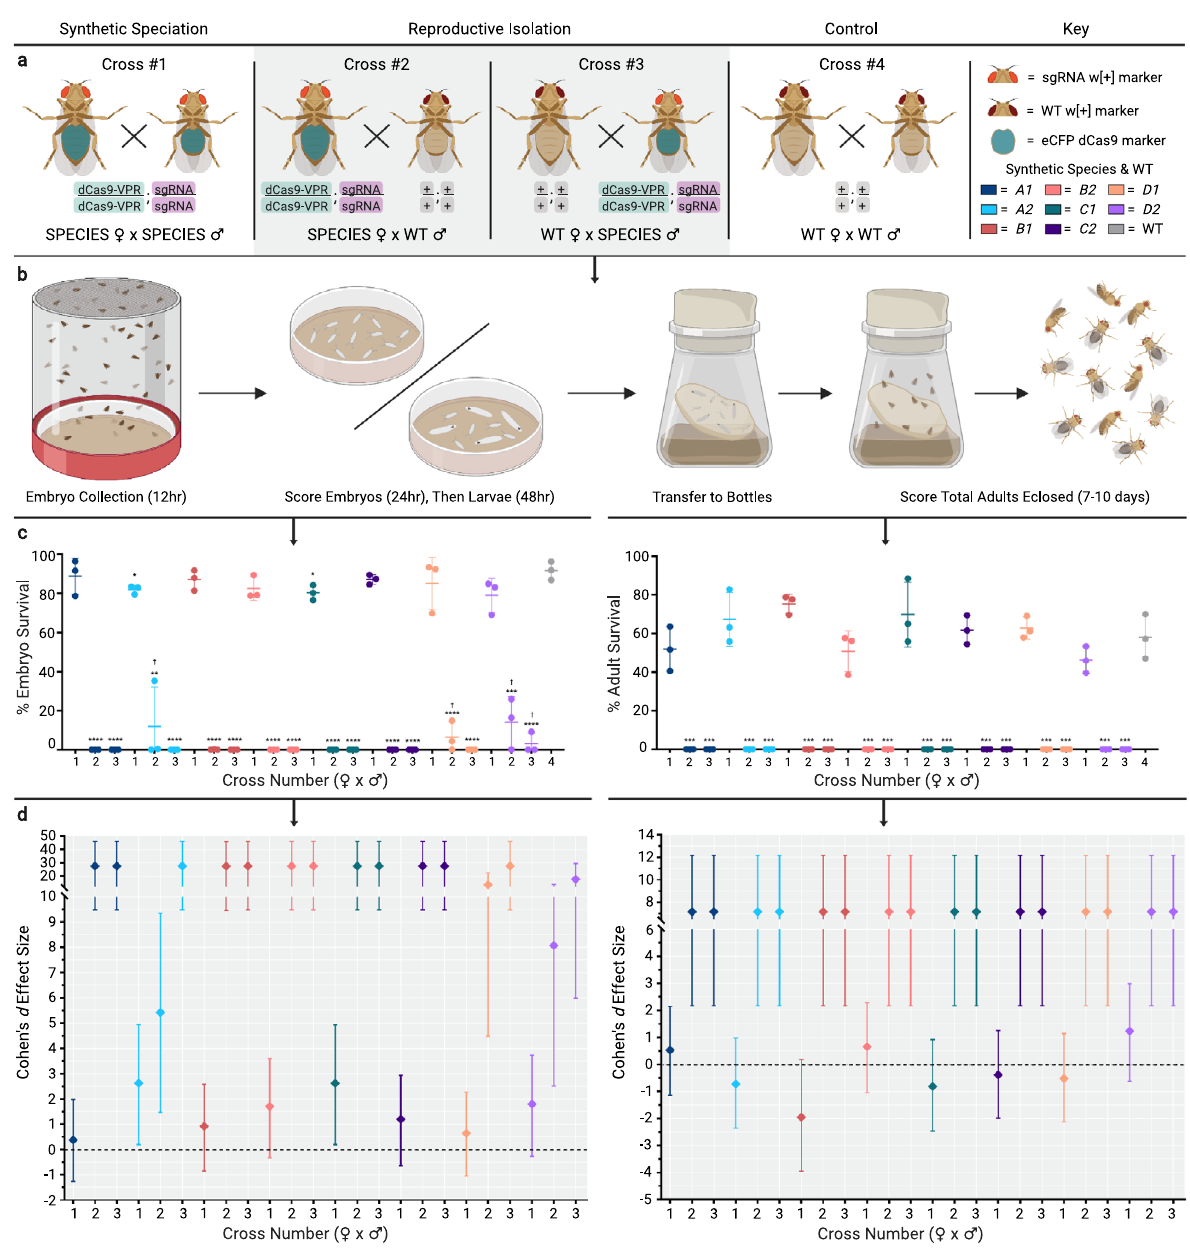
Fig. 2 Embryo and adult viability determination. a Crosses used to determine embryo and adult viability. (Cross #1) Homozygous dCas9-VPR;sgRNA “ SPECIES ” females crossed to homozygous dCas9-VPR;sgRNA SPECIES males. (Cross #2) Homozygous dCas9-VPR;sgRNA SPECIES females crossed to wildtype (WT) males. (Cross #3) WT females crossed to homozygous dCas9-VPR;sgRNA SPECIES males. Gray shaded background indicates expected lethal crosses. (Cross #4) WT females crossed to WT males. Each cross type was performed for all eight generated SPECIES (Fig. S3). b Schematic detailing the methods of determining embryo and adult survival compared to WT. c % embryo and adult survival was calculated and plotted. The number below each x -axis group indicates cross number (#1 – 4). N = 3 biologically independent replicates for each cross number. ✝ indicates that embryos did not survive past L1/L2 stages. Unpaired two-tailed t -tests were performed for each SPECIES compared to WT (* p < 0.05, ** p < 0.01, *** p < 0.001, and **** p < 0.0001). Middle lines indicate mean, while error bars represent standard deviation. The color of the dots represent each species as indicated in fi gure key. d Embryo (left graph) and adult (right graph) Cohen ’ s d effect sizes compared to WT. N = 6 observations per cross number per SPECIES (effect size based on mean comparison between three replicates of each experimental cross (#1 – 3) to control cross (#4)). Error bars represent 95% con fi dence interval. The color of the dots represent each species as indicated in fi gure key. Source data are provided as a Source Data fi